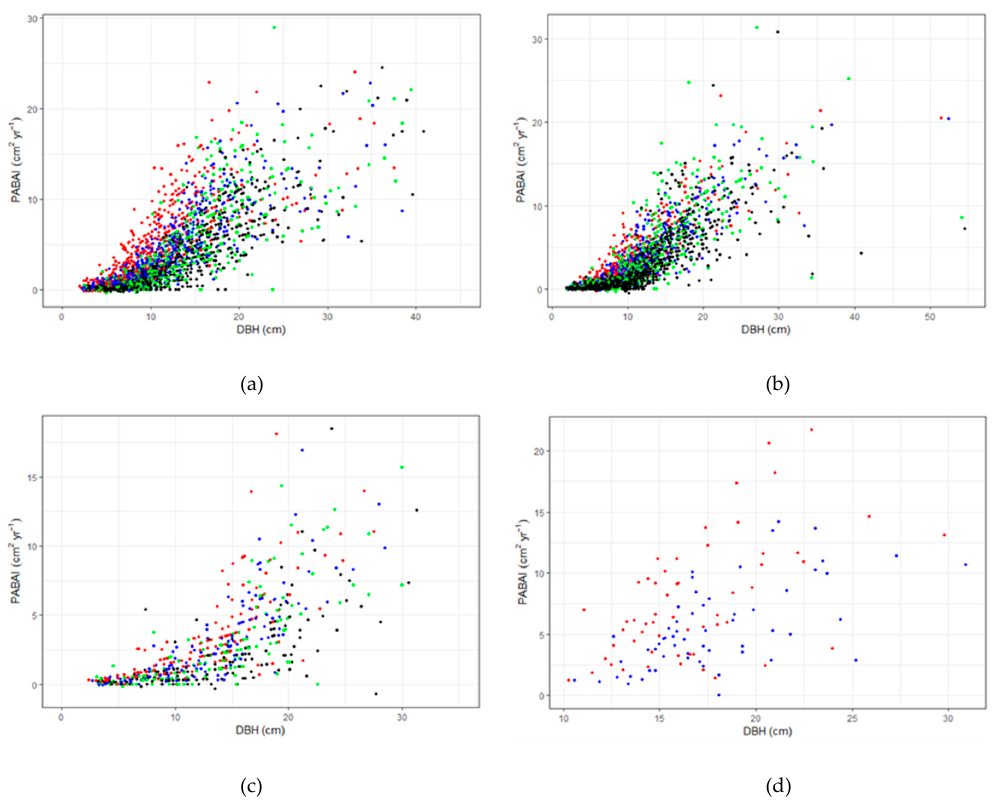
Figure A1. Measured periodic annual basal area increment (cm 2 yr − 1 ) versus DBH (cm) for ( a ) interior Douglas-fir, Block C; ( b ) interior Douglas-fir, Block D; ( c ) Spruce, Block D; and ( d ) lodgepole pine, Block D. The red, blue, green, and black colors represent the 1993–1997, 1997–2004, 2004–2008, and 2008–2013 growth periods, respectively.